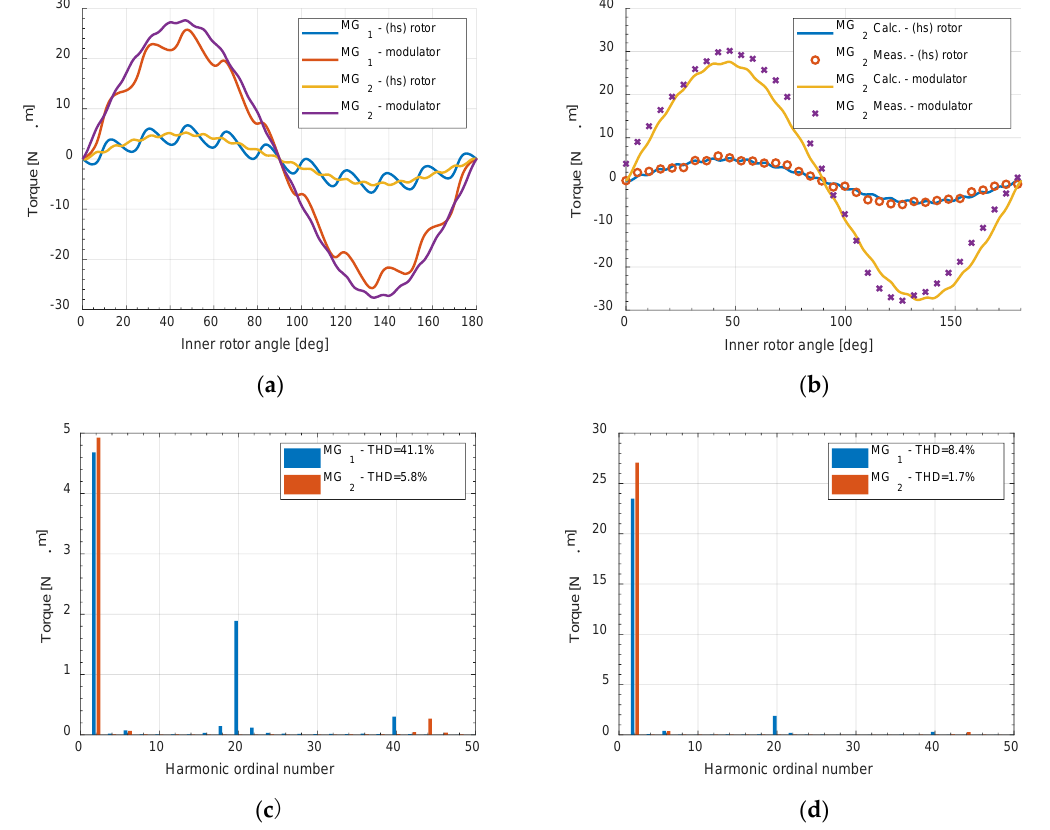
Figure 3. ( a ) Calculated torque characteristics for AFMGs with ratios 5:1 and 5.5:1, ( b ) comparison of calculations with measurements for MG 2 , ( c , d ) FFT spectra for high-speed (hs) rotor and modulator torque, respectively.